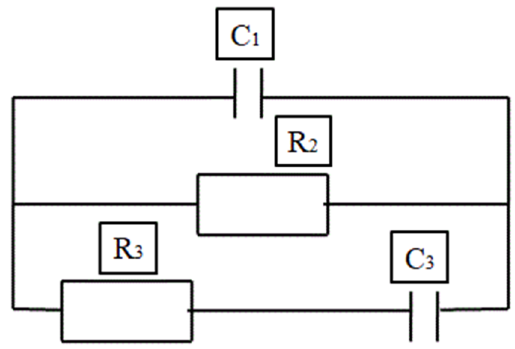
Figure 14. The circuit model for the hydration study.